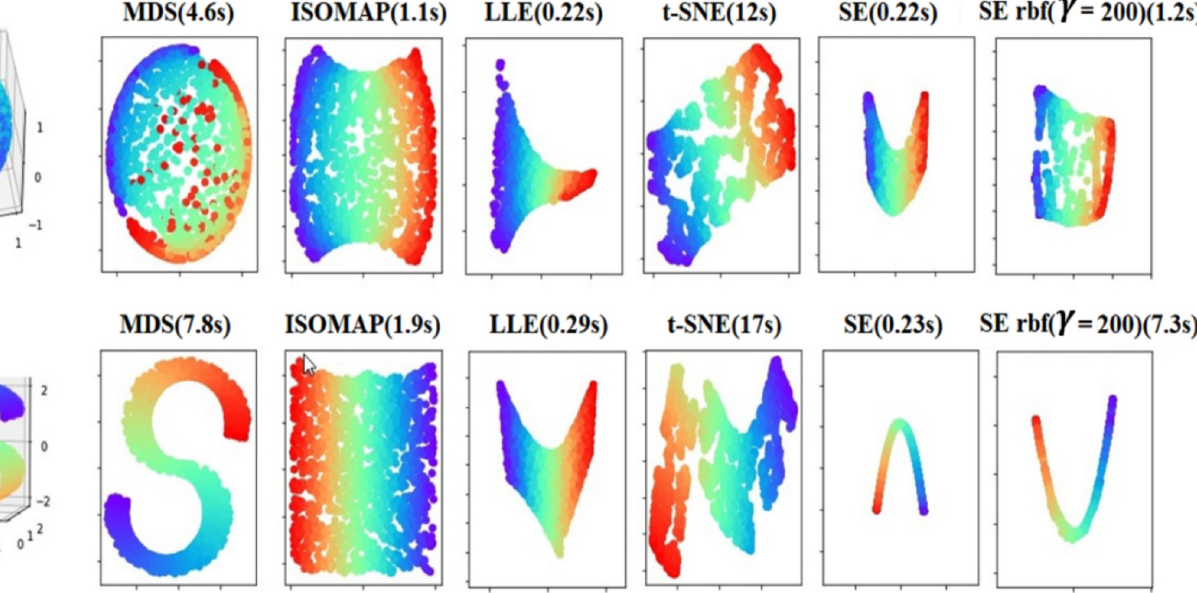
Fig 4. Manifold learning techniques. MDS, ISOMAP, LLE, t-SNE, and Spectral embedding (SE) or Laplacian Eigenmaps on 2000 points randomly distributed on the surface of a sphere. Computation time in seconds is given after each method’s name in parentheses. The first column for SE is simple-minded constructing weight matrix and the last column is for heat